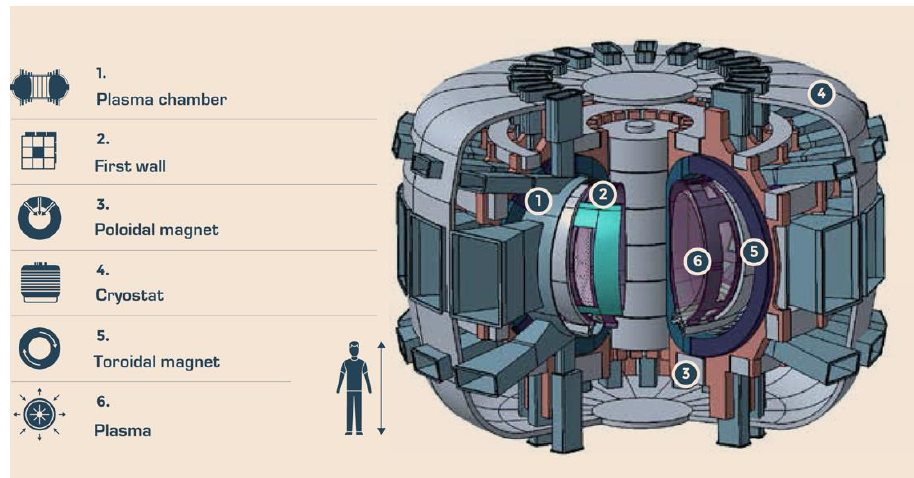
Figure 2. 3D cross section of divertor tokamak test (DTT).